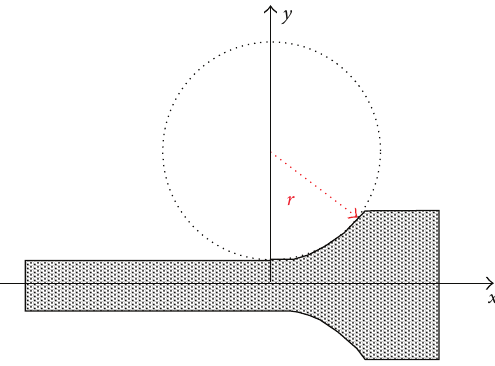
Figure 4: Top plane trace of the transition ( 𝑟 = 73